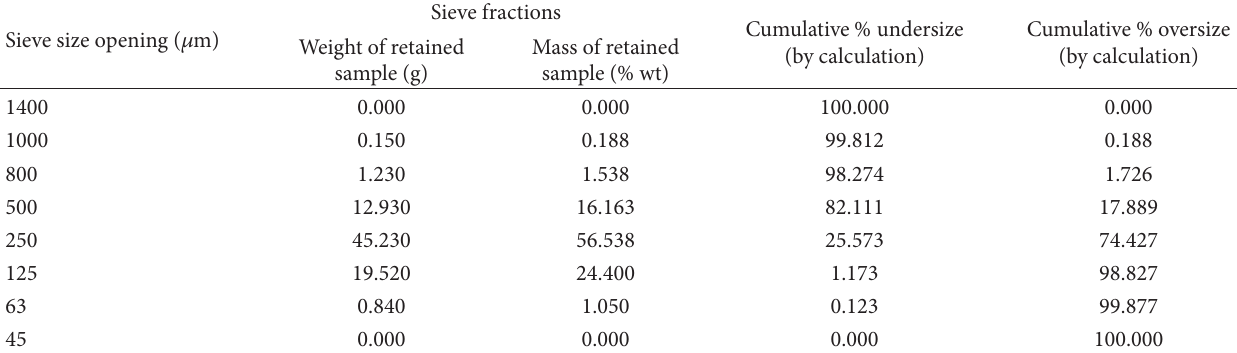
T 2: Sieve analysis results for oily POME